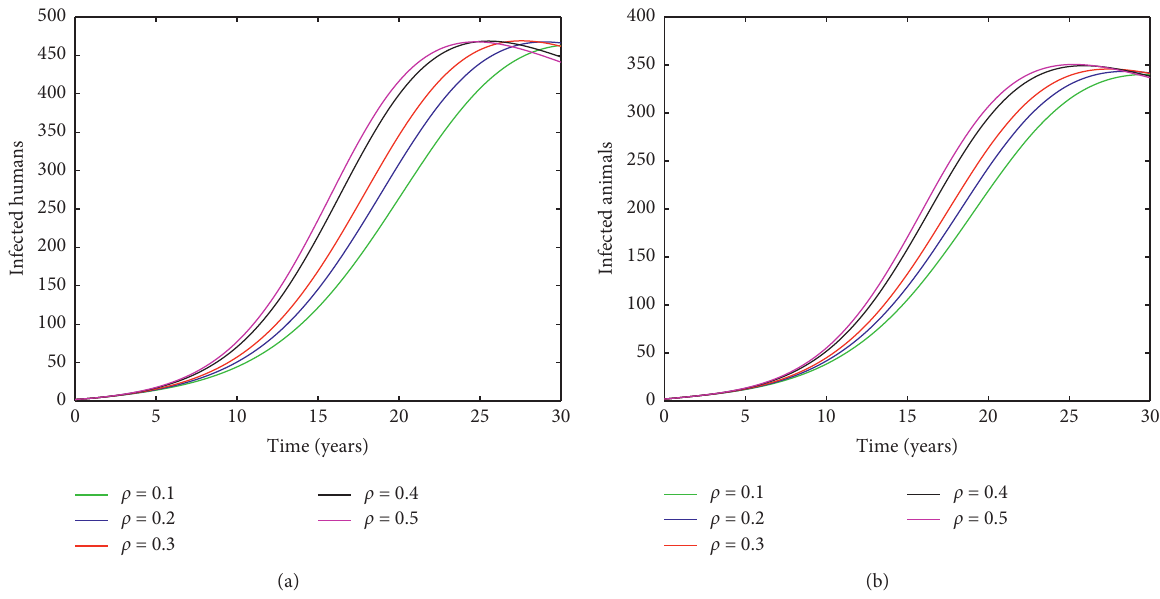
Figure 4: Variation of the dairy production rate into infected (a) humans and (b) animals with change in